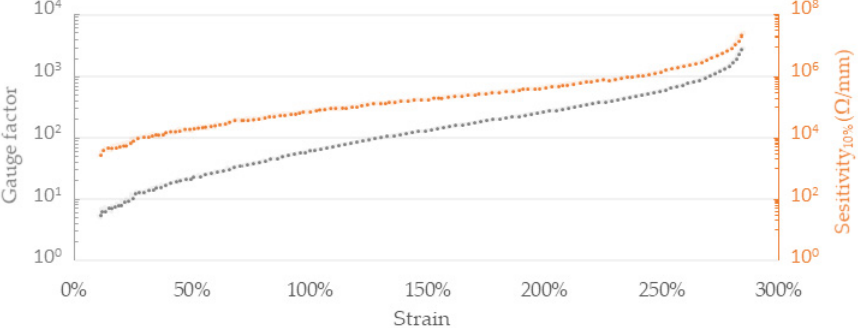
Figure 4. Gauge factor (GF) and sensitivity (S 10% ) calculated as a function of strain for 10 mm FM1 fi- ber.